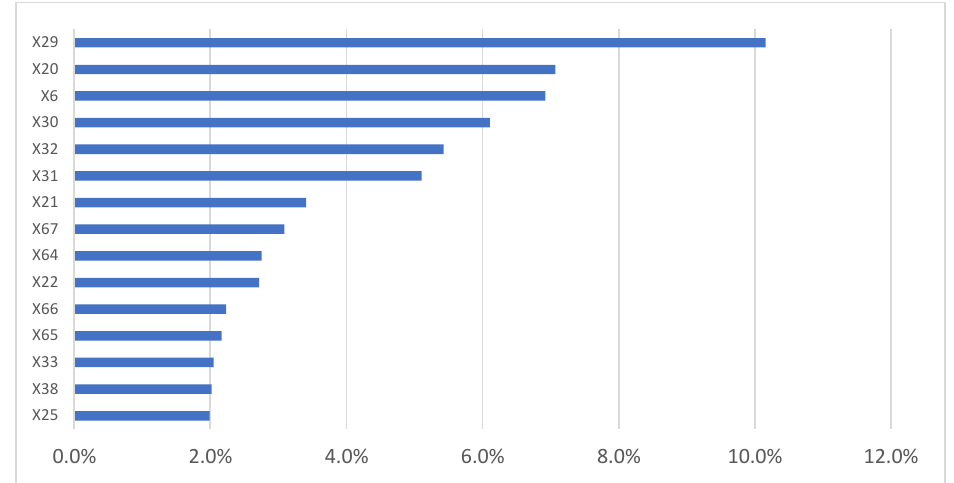
Figure 4. The 15 independent variables most influencing the annual per capita waste production (variable = X4).